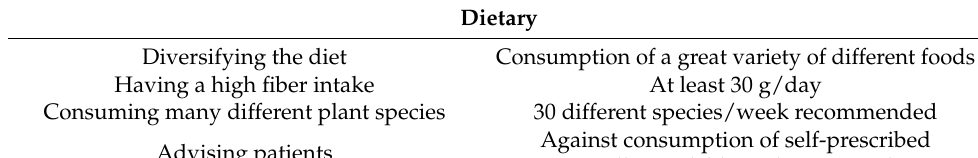
Table 3. Dietary and general main recommendations for patients receiving